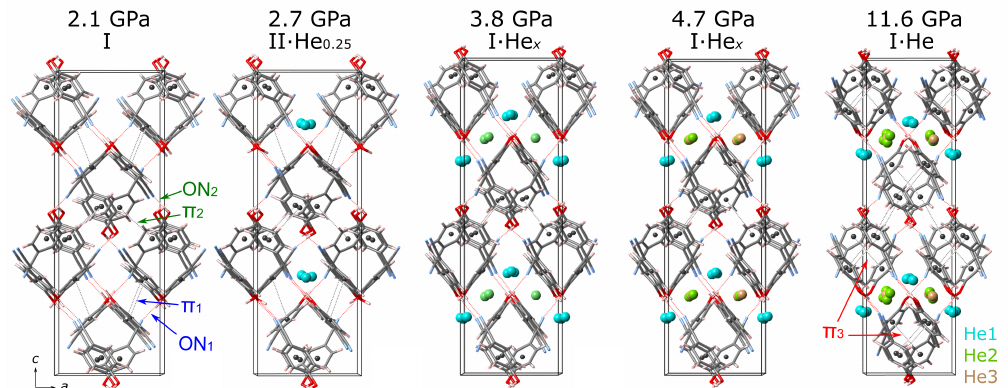
Figure 3. Structures of 4HCB compressed in He, with the coloured spheres representing the refined He positions on increase in pressure. The dotted grey lines indicate π − π interactions between the centroid positions of the benzene rings (dark grey spheres), and the dotted red lines show the O · · · N distances involved in hydrogen bonding